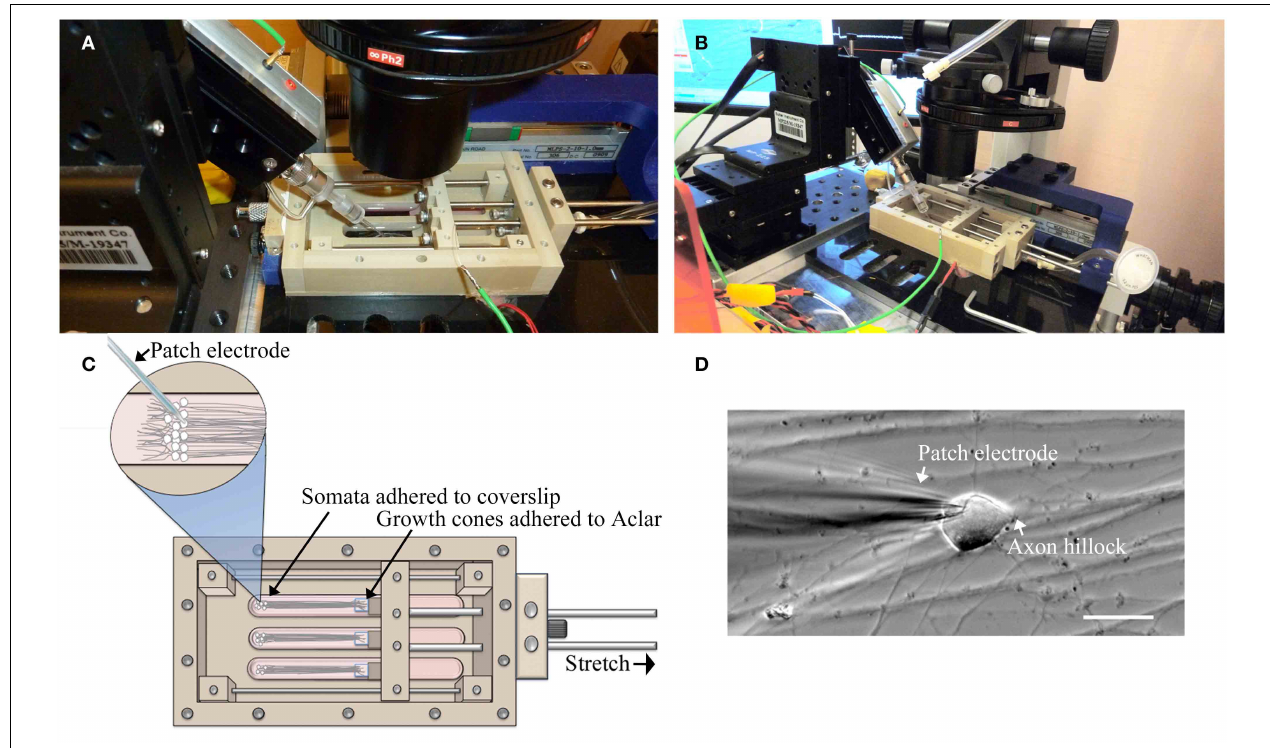
FIGURE 2 | Patch-clamp recording of neuronal somata during axon stretch. (A) Patch-clamp head stage positioning within an elongated well of a customized stretch-grown bioreactor. (B) Overview of head-stage, linear